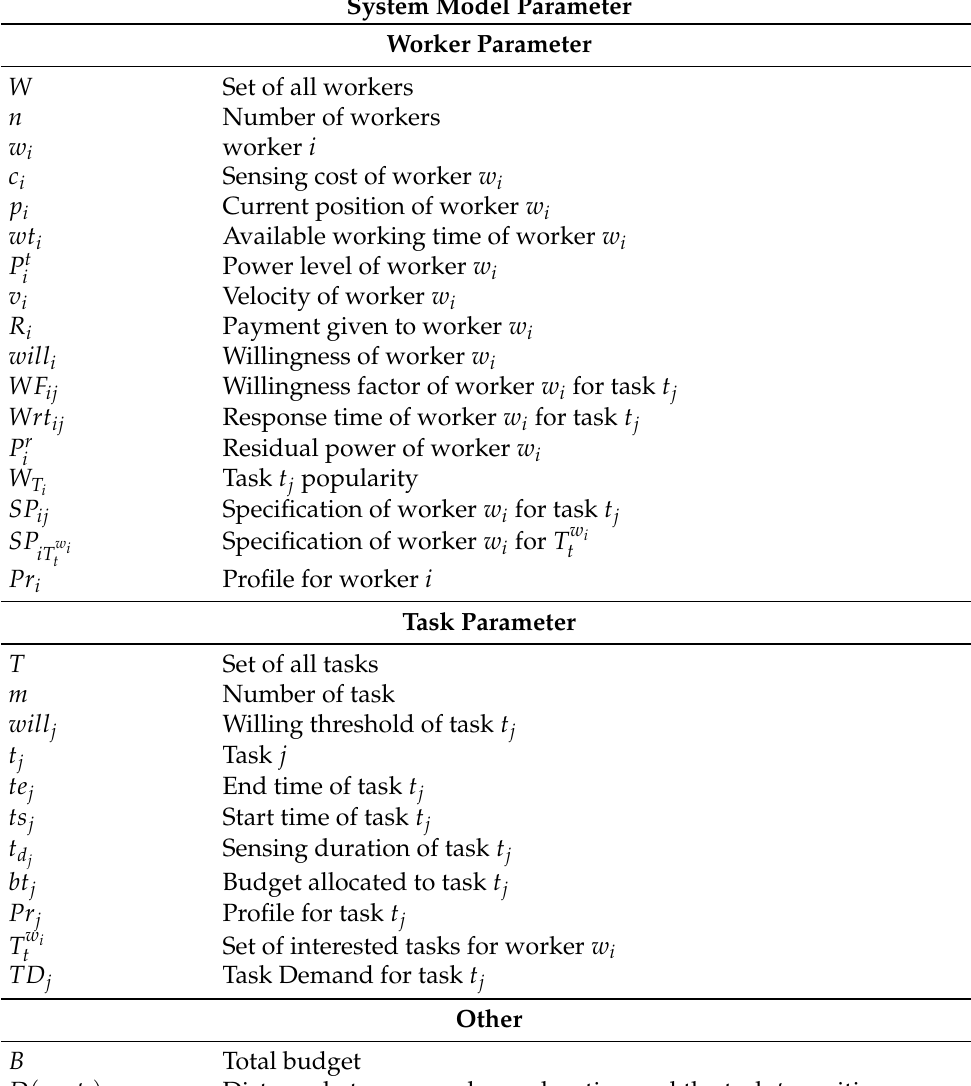
Table 1. Model Parameters